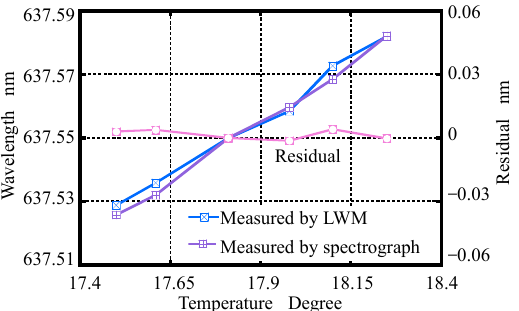
Figure 10. Wavelength measured by the LWM and the spectrometer under various temperatures.